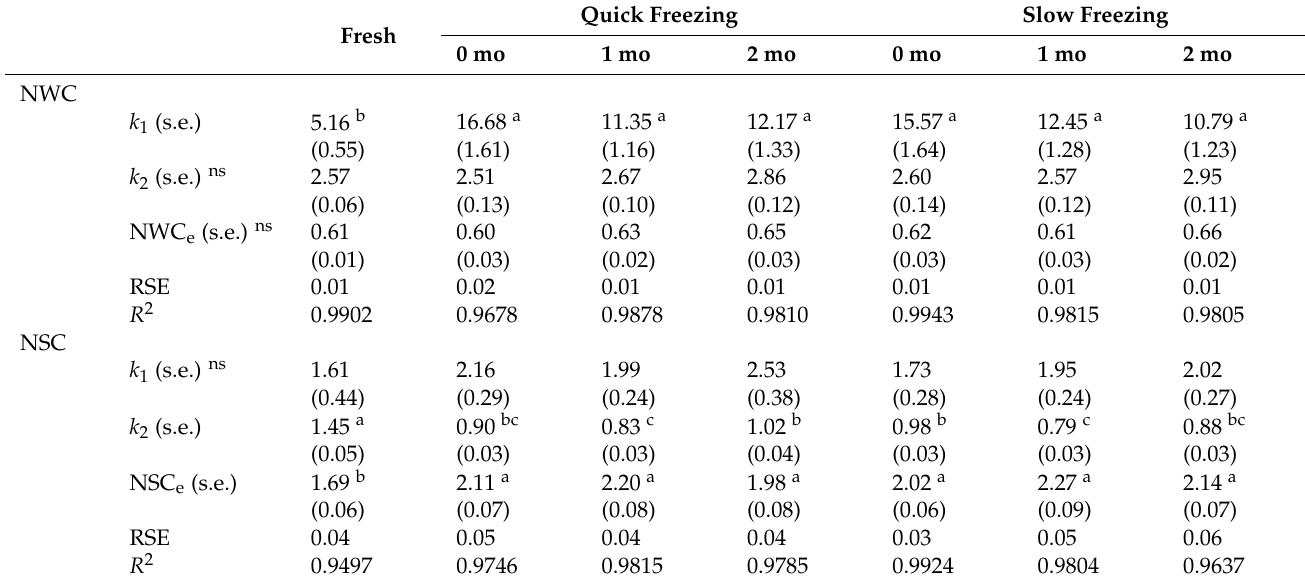
Table 1. Parameters ( k 1 and k 2 ) and their standard errors (s.e.) from Peleg’s model for describing NWC and NSC in osmotic dehydration of